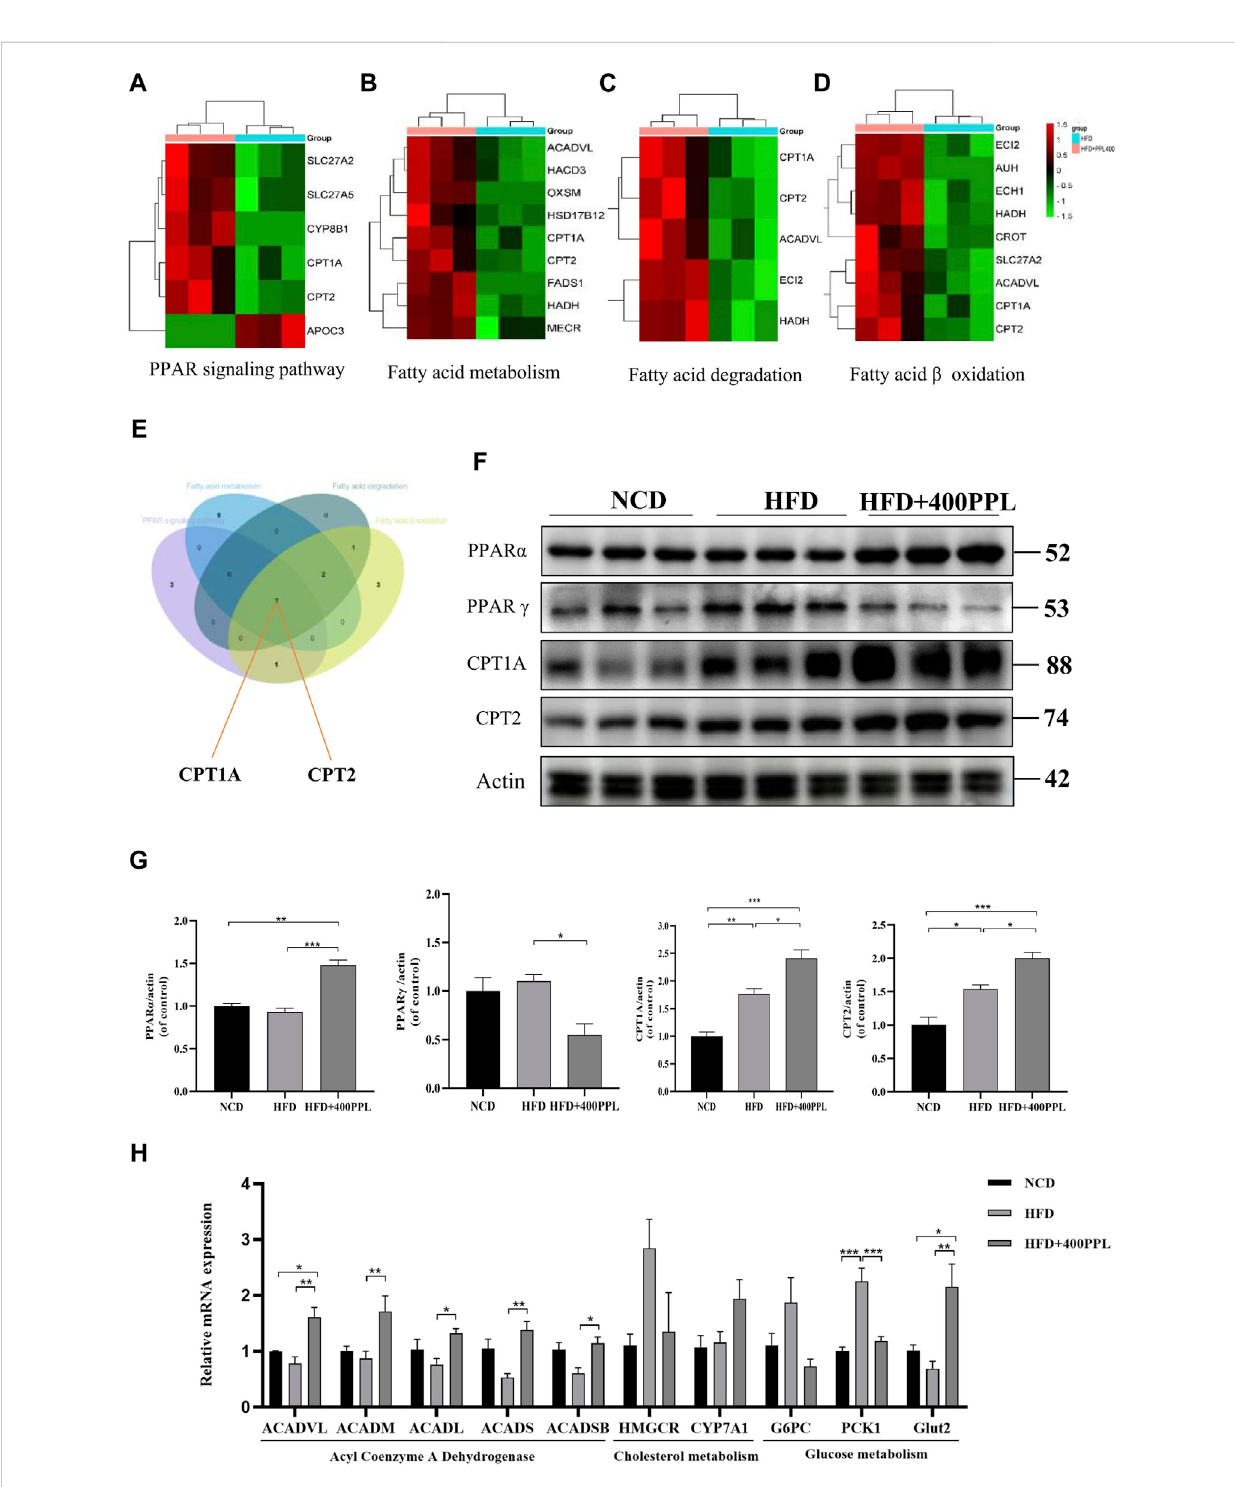
FIGURE 4 PPL improved disturbance of lipid metabolism via PPARs/CPT1A/CPT2-mediated FAO. (A – D) Differential proteins related to PPAR signal pathway, Fatty acid metabolism, Fatty acid degradation and Fatty acid β oxidation signi fi cantly upregulated and downregulated in proteomics analysis from mice treated with HFD or HFD + PPL therapy. (E) Key proteins between differential proteins from PPAR signal pathway, Fatty acid metabolism, Fatty acid degradation and Fatty acid β oxidation. (F) Expression levels of key proteins PPAR α , PPAR γ , CPT1A and CPT2 in PPAR signaling pathway. (G) Relative protein levels were compared to the NCD group after normalized to β -actin (n = 3 per group). (H) The relative mRNA levels related to glucose-lipid metabolism inthe liver wereanalyzed.(n = 4-5 per group). Data were expressed as themean ± SEM. Differencesamong groups were compared byone- way ANOVA. * p < 0.05, ** p < 0.01, *** p <